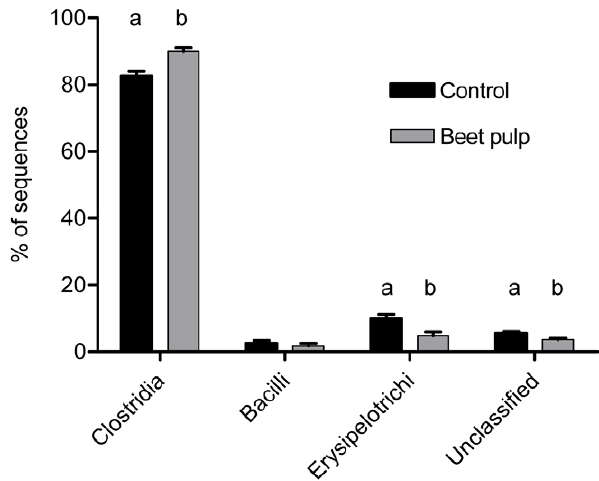
Figure 3. Changes within Firmicutes in fecal samples of dogs fed diets with and without supplemental fiber. Class assignments according to the Ribosomal Database Project classifier (v10.2; $ 80% confidence). ab Columns within class not sharing letters are different (P , 0.05).